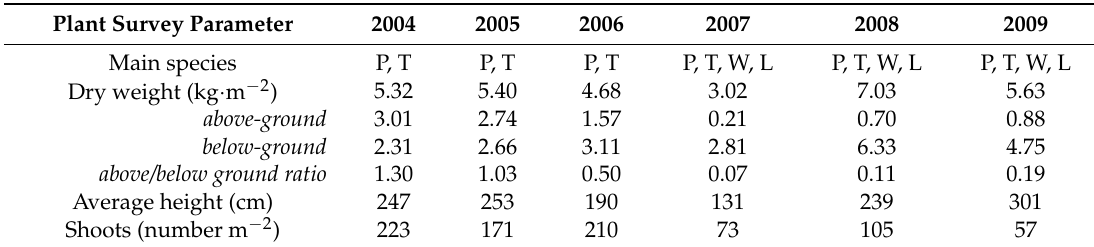
Table 4. Agronomic results of plant